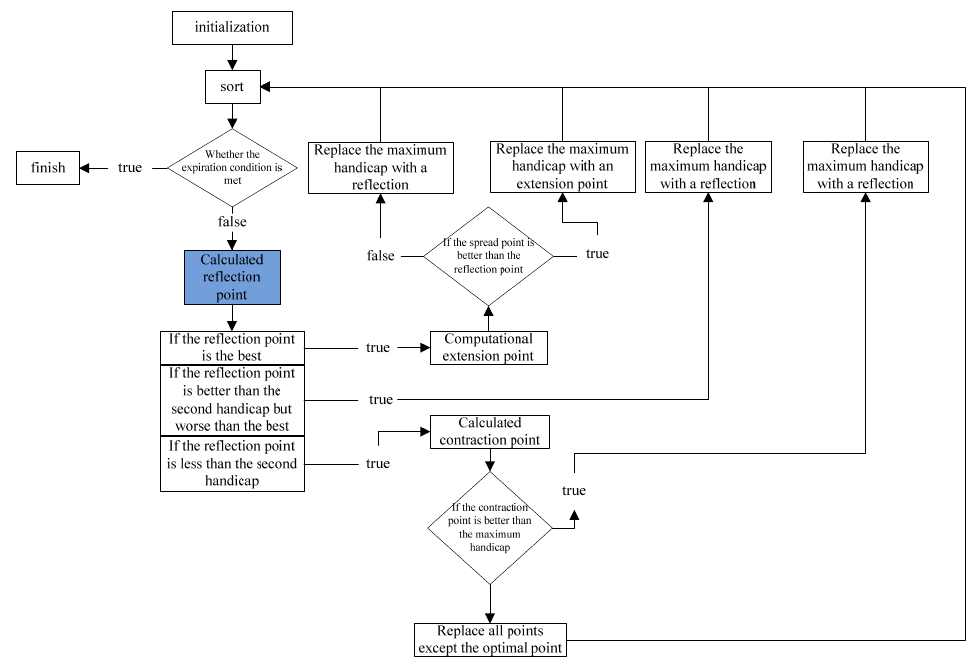
Figure 16. Nelder-Mead function optimization logic diagram. Table 6. The results of 20 iterations after function